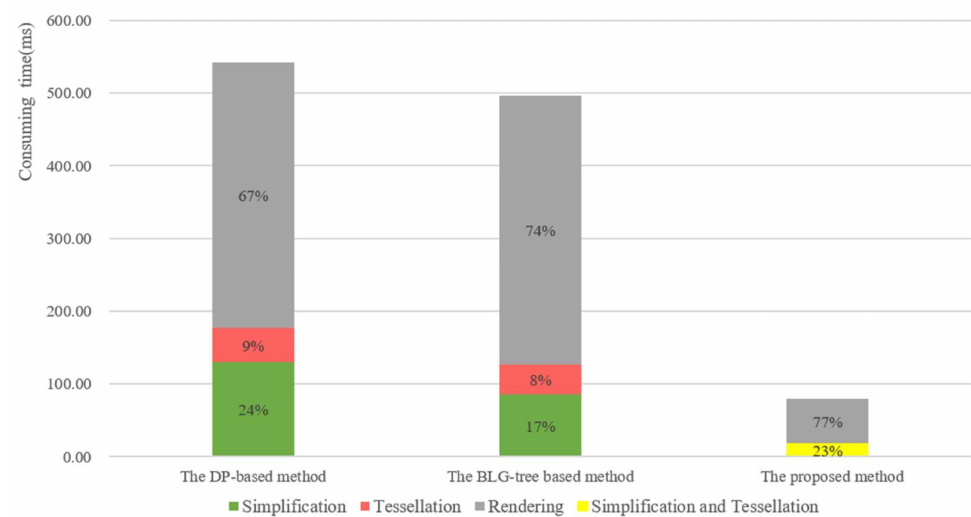
Figure 9. Detailed statistics of the time costs (in milliseconds) of the simplification, tessellation and rendering